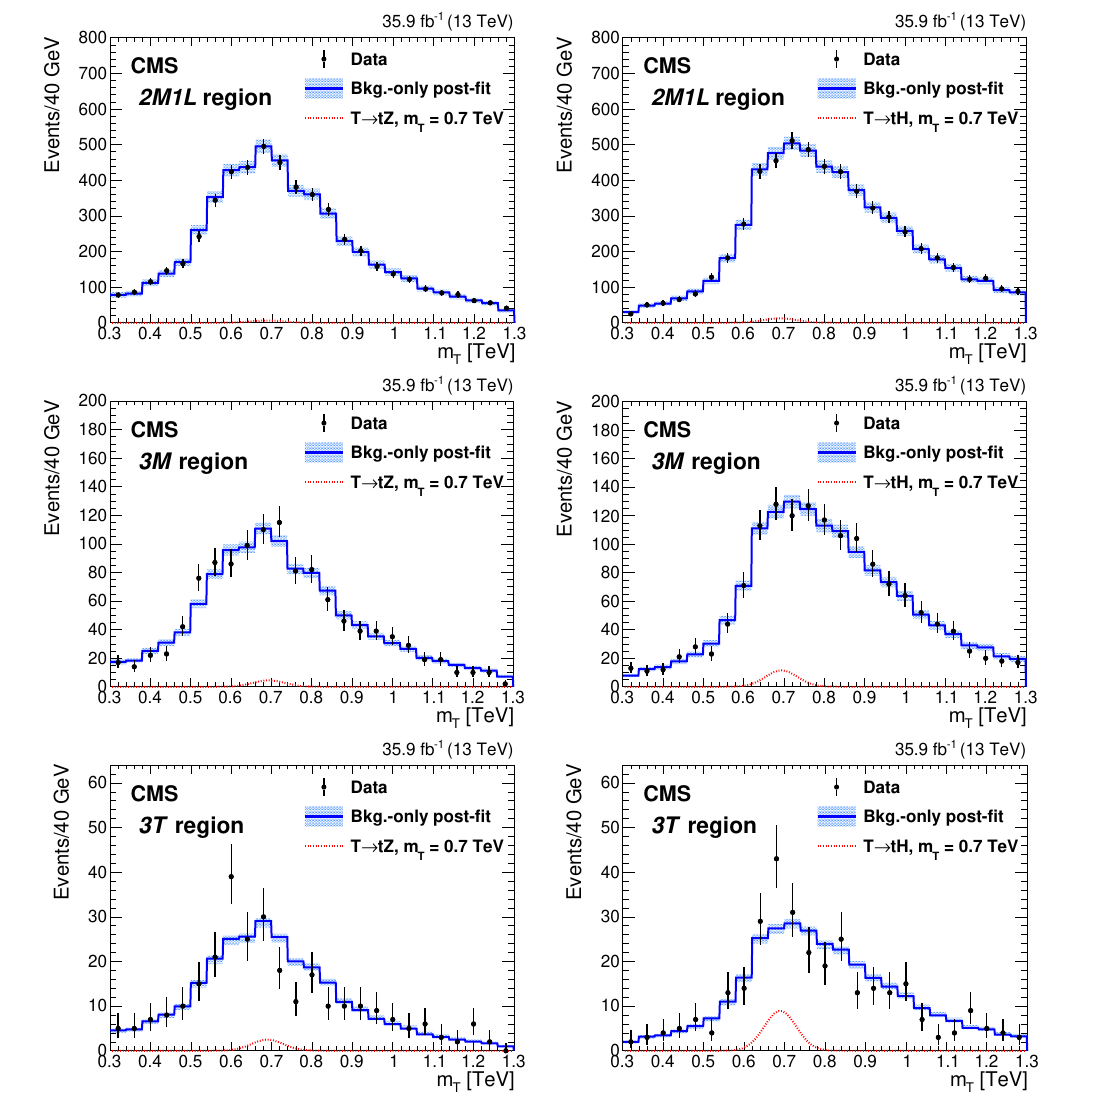
Figure 4 . The background-only post-(cid:12)t invariant mass distributions for the tZ candidates (left) and tH candidates (right) for each region (cid:12)tted: 2 M 1 L (upper row), 3 M (middle row), and 3 T (lower row). The signal hypothesis shown is a T with a mass of 0.7 TeV, narrow width, and a product of the cross section and branching fraction of 600 fb for the tZbq and tHbq channels. The data are represented by the black points with error bars, the signal hypothesis is represented by the red dashed line, the blue histogram gives the (cid:12)tted background, and the light blue band represents the uncertainty in the background